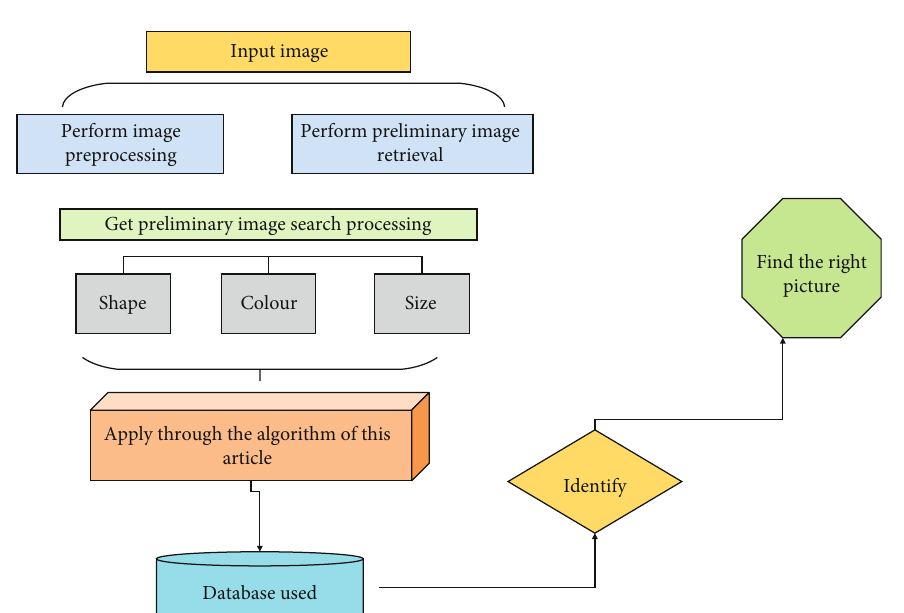
Figure 1: Step-by-step diagram of the SIFT algorithm.